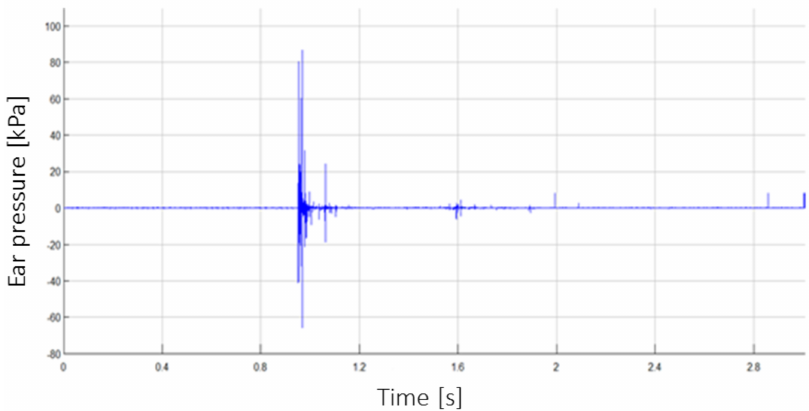
Figure 12. The ear pressure registered during detonation of 10 kg TNT under the wheel